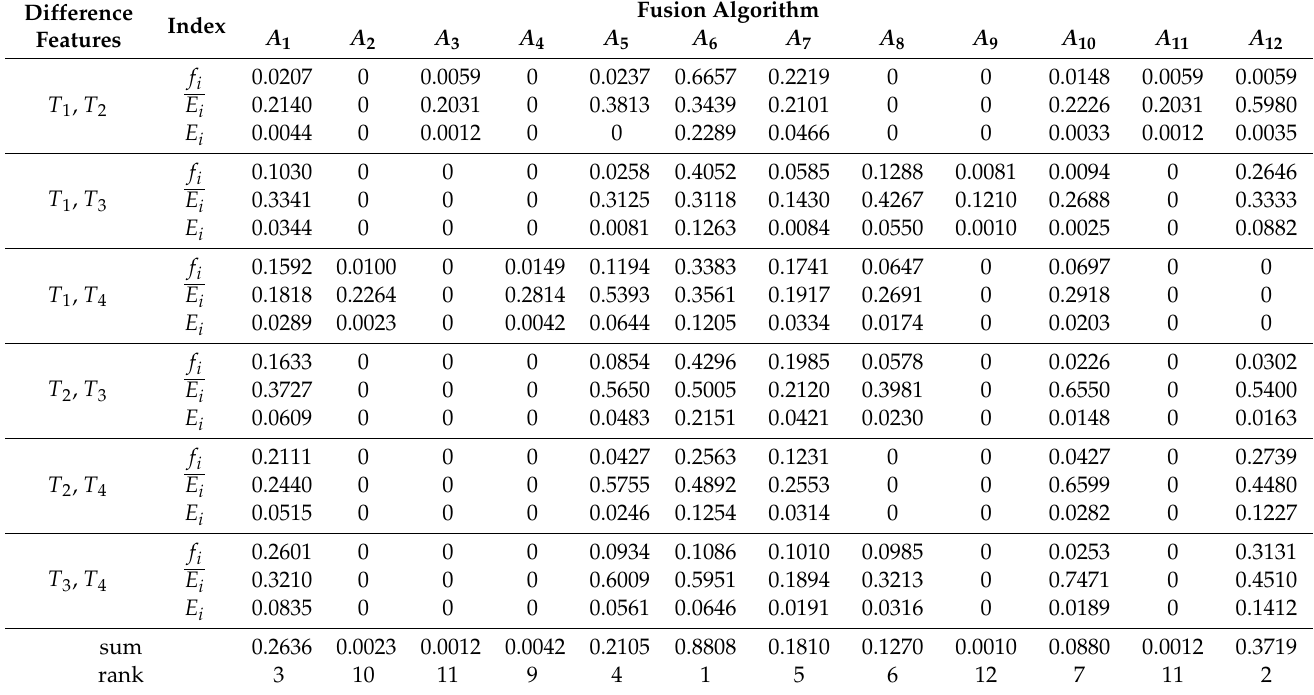
Table 5. E i of each fusion algorithms of the first group.